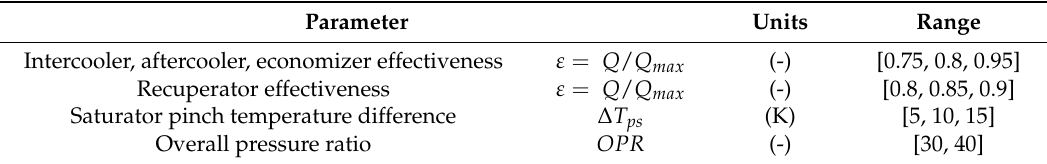
Table 1. Range of parameters across which the parametric study was conducted.